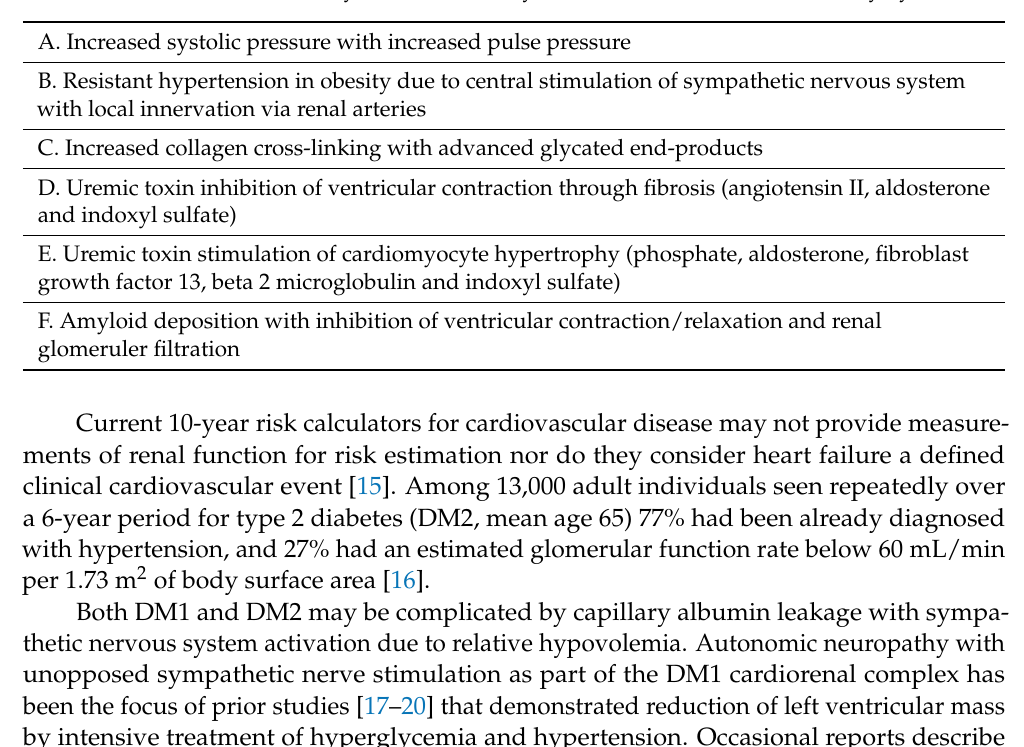
Table 1. Mechanisms of cardiac dysfunction that may interact with mechanisms of kidney